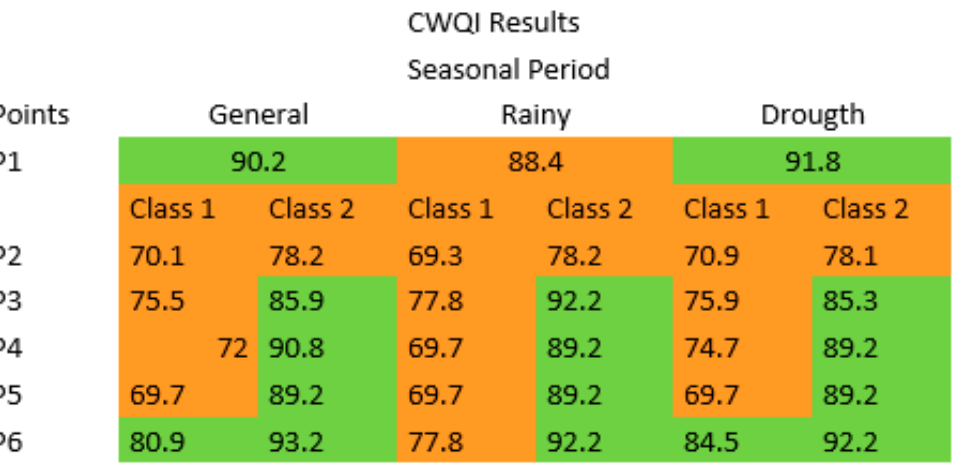
Table 5. Characterization of mutagenicity and cytotoxicity of water samples from Buritis Lake by the A. cepa test.